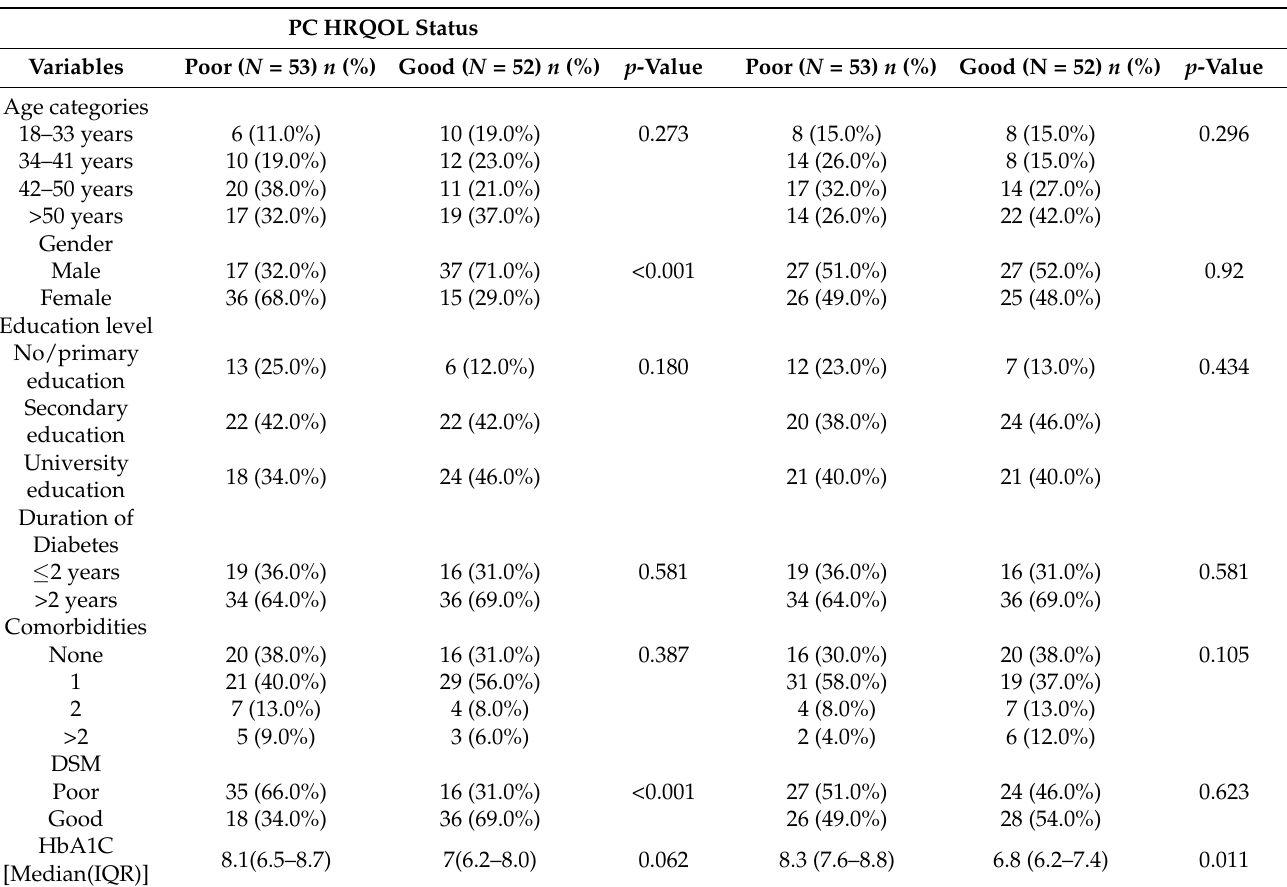
Table 4. PC and MC of HRQOL status according to baseline characteristics of participants with diabetes attending PHCC in Qatar.